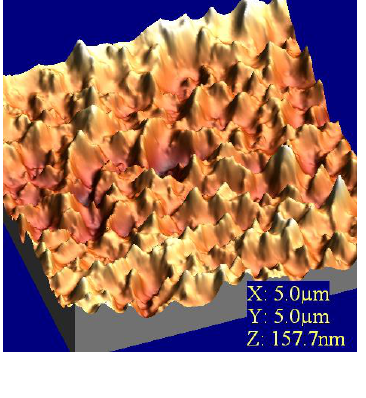
Figure 9. Surface topography of phospholipids/ 2 /GOx LS